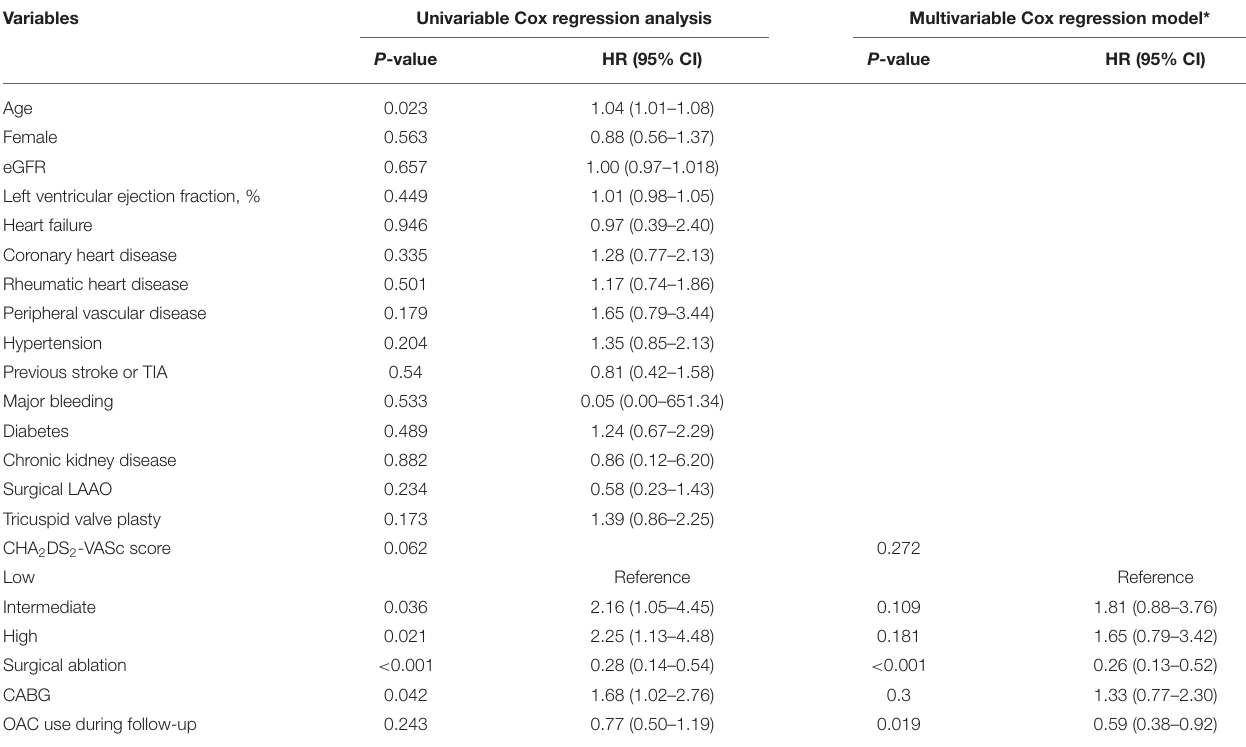
TABLE 4 | The factors associated with thromboembolism in patients with atrial fibrillation and bioprosthetic valve ( n = 903).